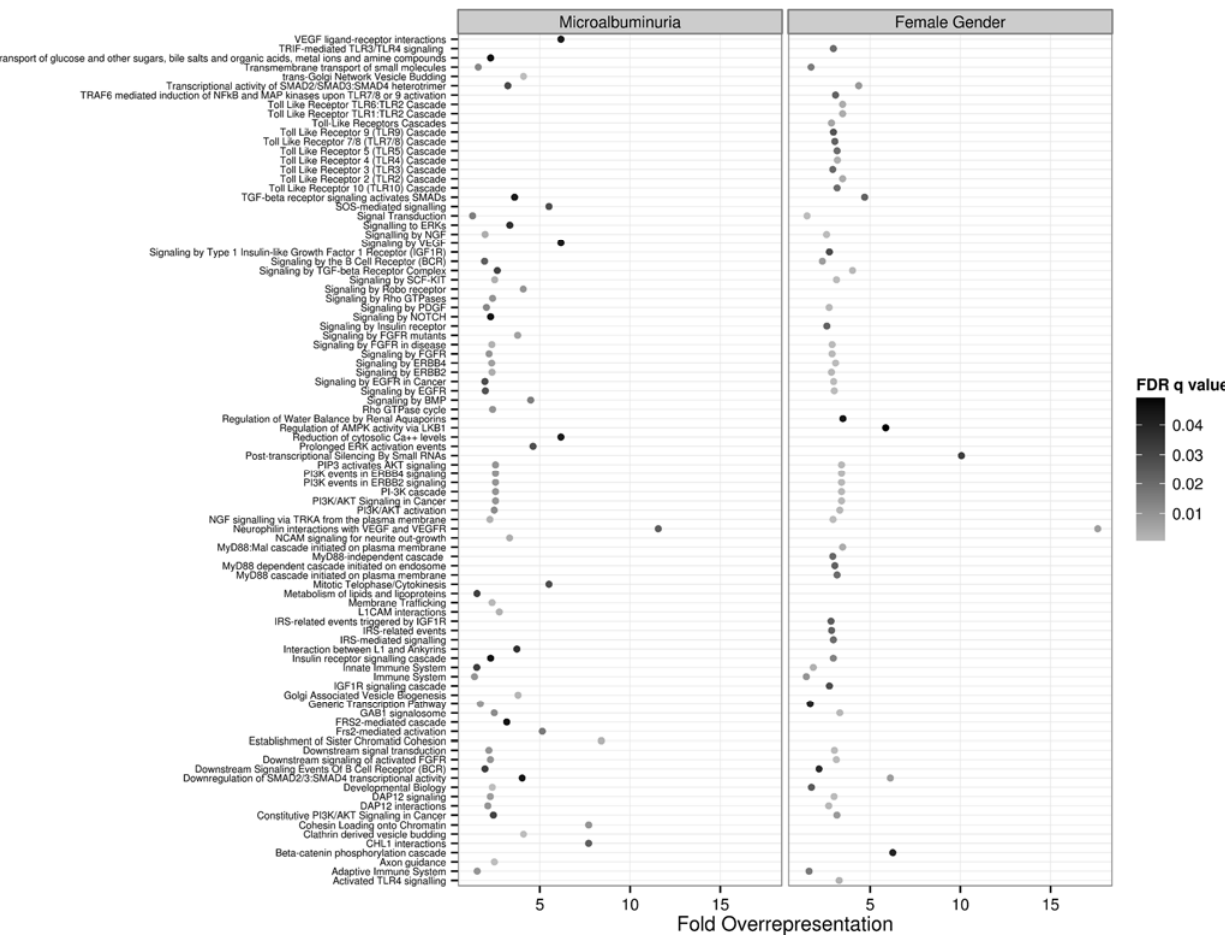
Figure 2. Over-representation analysis in the REACTOME ontology of putative targets of differentially expressed microRNAs in patients with MA and women plotted side by side. The fold-overrepresentation of terms in each pathway is plotted in the x-axis, while the statistical significance (False Discovery Rate adjusted q value) is encoded in gray